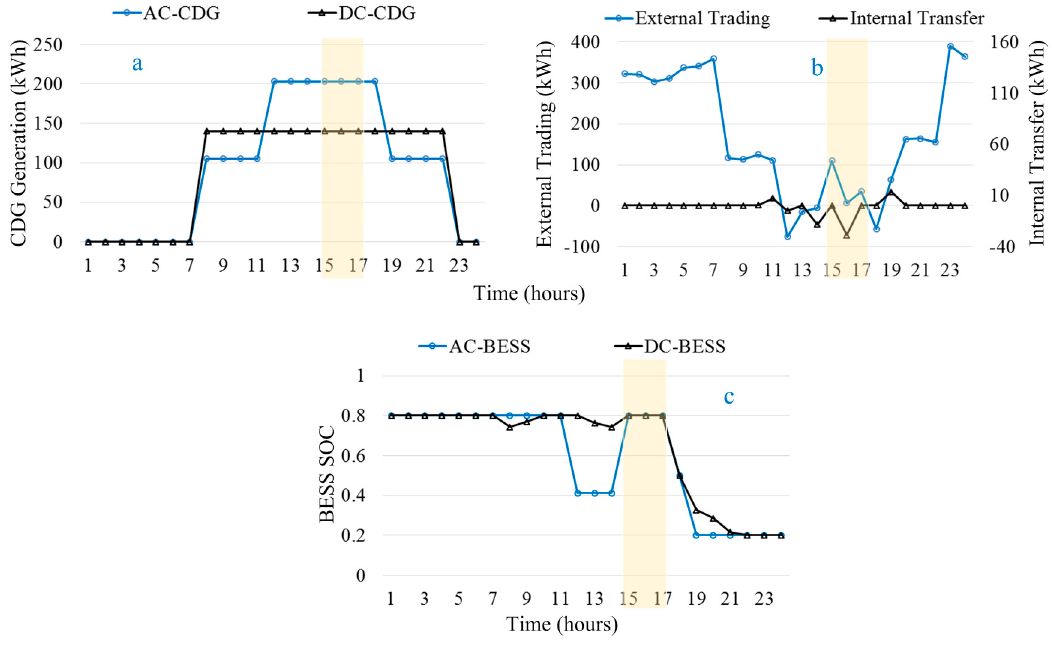
Figure 12. Operation results of proposed strategy: ( a ) CDG generation; ( b ) power trading; ( c ) BESS SOC.